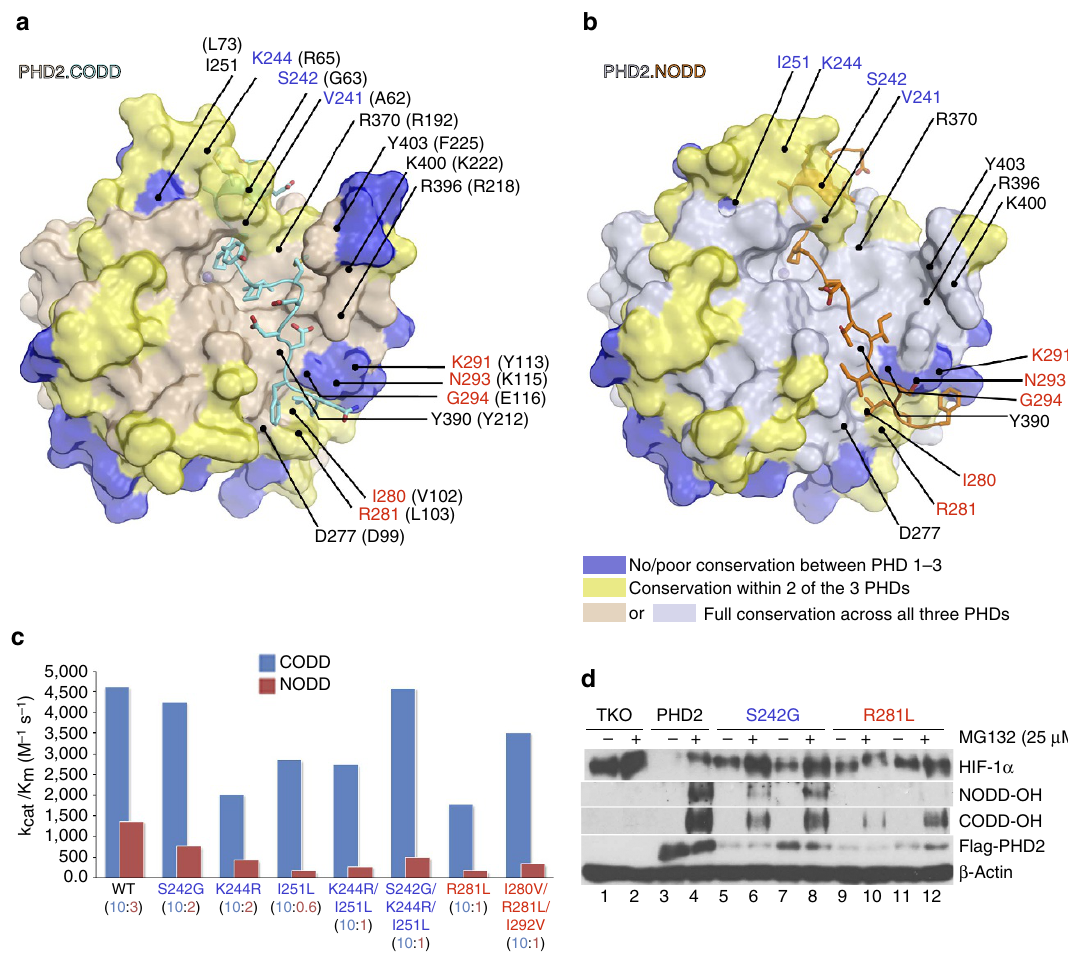
Figure 5 | Combined biophysical and biochemical analyses identify NODD/CODD selectivity determinants in the PHDs. Surface representations of ( a ) PHD2.CODD and ( b ) PHD2.NODD complexes showing sequence differences that inform on selectivity determinants in addition to clinically observed variant sites (Pro317, Arg371 and Arg396) (Supplementary Fig. 1 gives a sequence alignment of PHDs). ( c ) Catalytic efficiencies ( k cat / K m ) of PHD2 wt and the variants for hydroxylating CODD and NODD; values in the parentheses are CODD/NODD activity ratios; selected variants were tested in cells ( d ). Assays of the indicated PHD2 variants in TKO cells as described in Fig. apparently positions the regions in ODD binding raises the possibility of identifying inhi- bitors that compete differently with NODD or CODD. Indeed, we found that FG2216 (IOX3) 35 , used in clinical trials for treatment of anaemia, preferentially displaces NODD over CODD from PHD2 (Fig. 2c). Analysis of PHD2.FG2216 complex structures, with and without CODD (PDB: 3HQU, 4BQX), suggests this is because of the relatively greater role of the LXXLAP region in NODD compared with CODD binding (with CODD, loss of LXXLAP binding is compensated by interactions involving C-terminal regions). In contrast, FG4592 (Roxadustat) 35 , a newer compound in clinical trials 36 , efficiently displaces both CODD and NODD from PHD2 likely to be due to its phenoxy group, which projects into regions binding the residues C-terminal to the hydroxylated prolines of both ODDs (Supplementary Fig. 13). Notably, the selectivity of NODD/CODD displacement by the inhibitors differs for the R396T and P317R variants compared with wt PHD2. In the case of R396T (which does not hydroxylate CODD efficiently, 2b),